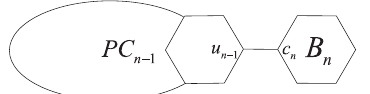
Figure 1: A polyphenyl chain PC n with n hexagons.